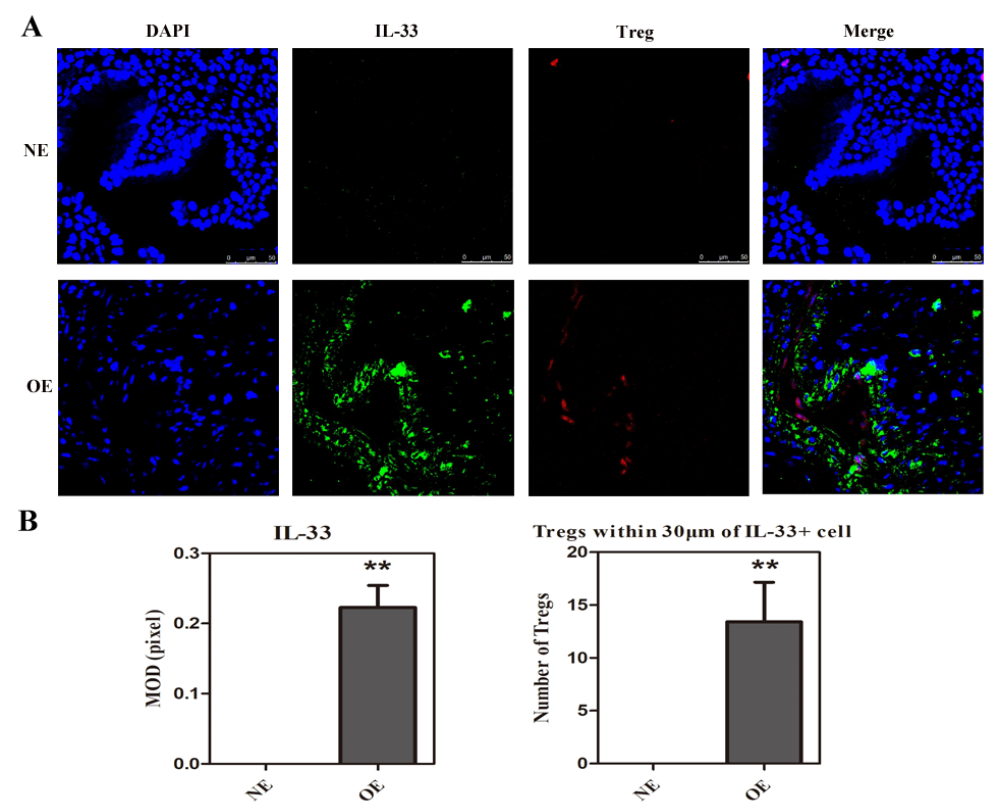
Figure 3. Colocalization of IL-33 and FOXP3 in ovarian endometrioma. ( A ). Representative im- munofluorescence staining of FOXP3 and IL-33 in normal endometrium and ovarian endometrioma lesions. Sections were co-stained for IL-33 (green), FOXP3 (red), and 4 ′ ,6 ′ -diamidino-2-phenylindole (DAPI; blue). Images were taken at 400× magnification. Scale bar = 50 μ m. ( B ). Summary of the immunofluorescence results of IL-33 by MOD (in pixels) and FOXP3 by counting the Tregs within 30 μ m of IL-33+ cells (n = 7). **: p < 0.01. Data are presented in means ± SDs. Abbreviations used: NE: normal endometrium; OE: ovarian endometrioma.